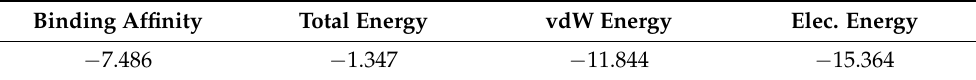
Table 9. The docking results of AIGT and